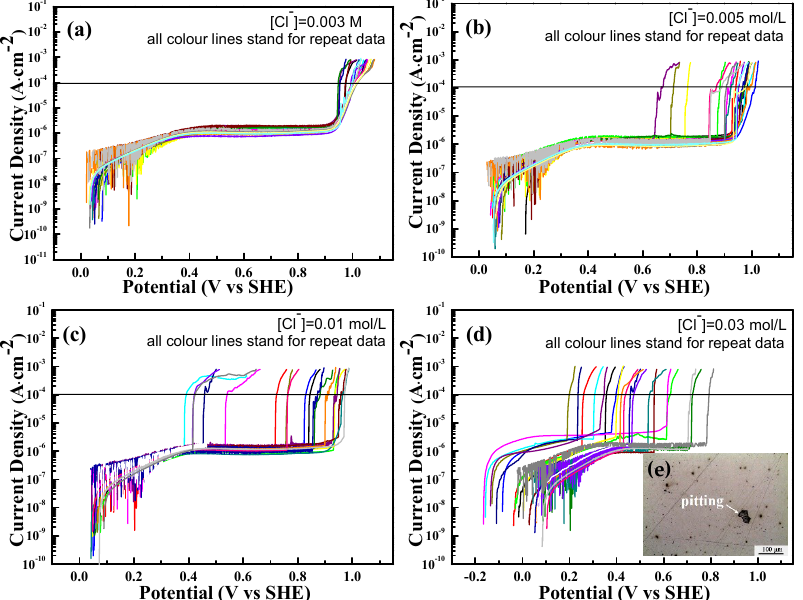
Figure 5. Anodic polarization curves for reinforcing bars in simulated concrete pore solutions with various concentrations of chloride ions at pH 12.0; ( a ) 0.003 mol/L, ( b ) 0.005 mol/L, ( c ) 0.01 mol/L, and ( d ) 0.03 mol/L. ( e ) shows the pitting corrosion after the anodic polarization test.